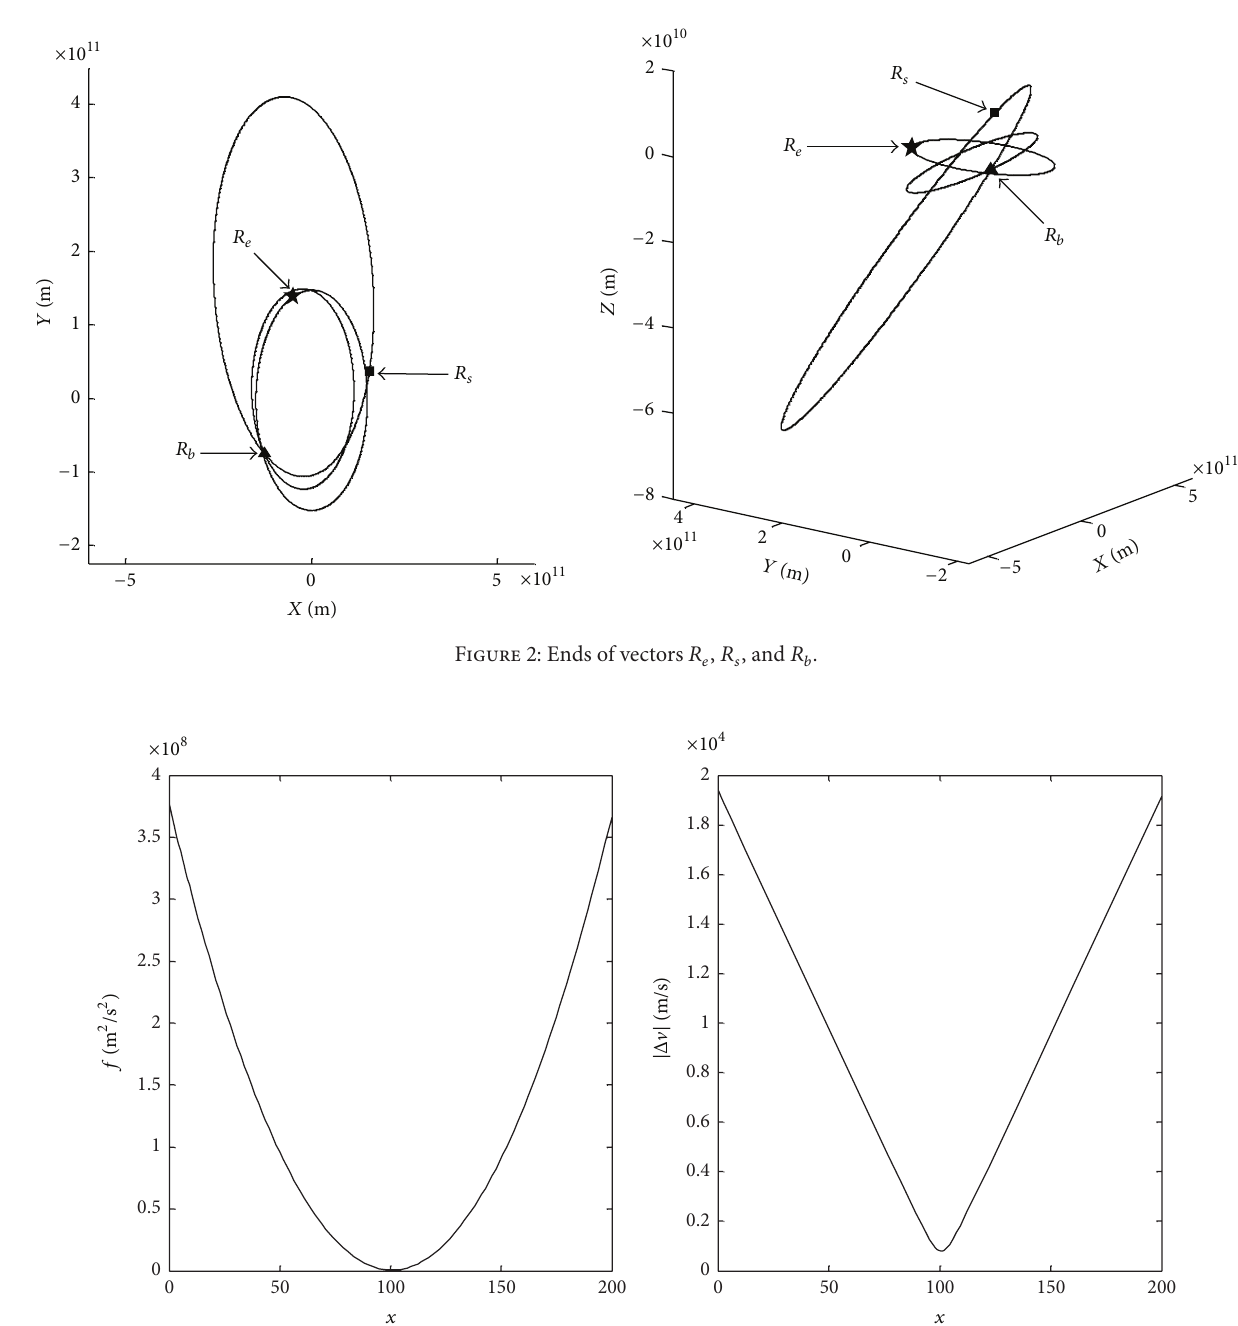
Figure 3: 𝑓 and |Δ V | .